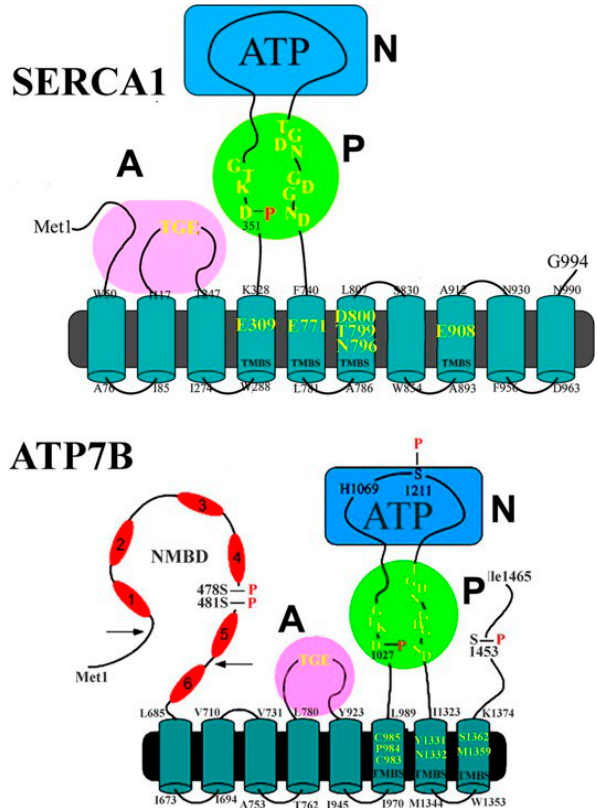
Figure 7. Two-dimensional folding models of the Ca 2+ ATPase (SERCA1) and Cu + ATPase (ATP7B) sequence. The diagram shows ten SERCA or eight ATP7B transmembrane domains including the calcium or copper binding sites (TMBS) involved in enzyme activa- tion and cation transport. The extra-membranous regions of both enzymes comprises a nucleotide binding domain (N), the P domain with several conserved residues (in yellow) including the aspartate (Asp351 and Asp1027) undergoing phopsphorylation to form the catalytic intermediate (EP), and the A domain with the TGE con- served sequence involved in catalytic assistance of EP hydrolytic cleavage. The His1069 residue whose mutation is frequently found in the Wilson disease is shown in the ATP7B N domain. Specific features of ATP7B are the N-metal Binding Domain (NMBD) extension with six copper binding sites, and serine residues under- going Protein Kinase assisted phosphorylation (Ser478, Ser 481, Ser1211, Ser1453).